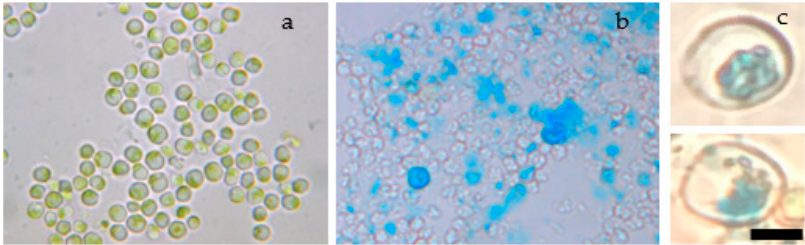
Figure 5. Time course of pulses used on the flow cuvette to execute electroporation. To verify the transfer of magnetic nanoparticles, Prussian blue staining was used to visualize them into the cytoplasm of microalgae cells (Figure 6a).